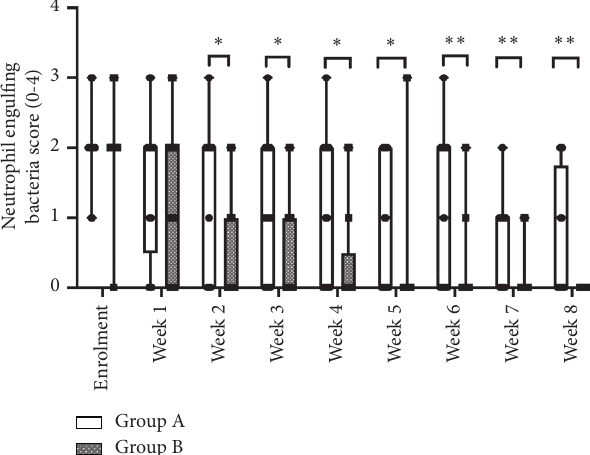
Figure 4: Average neutrophil engulfing bacteria scores by treat- ment and study week. ∗ p < 0 . 05; ∗∗ p < 0 .